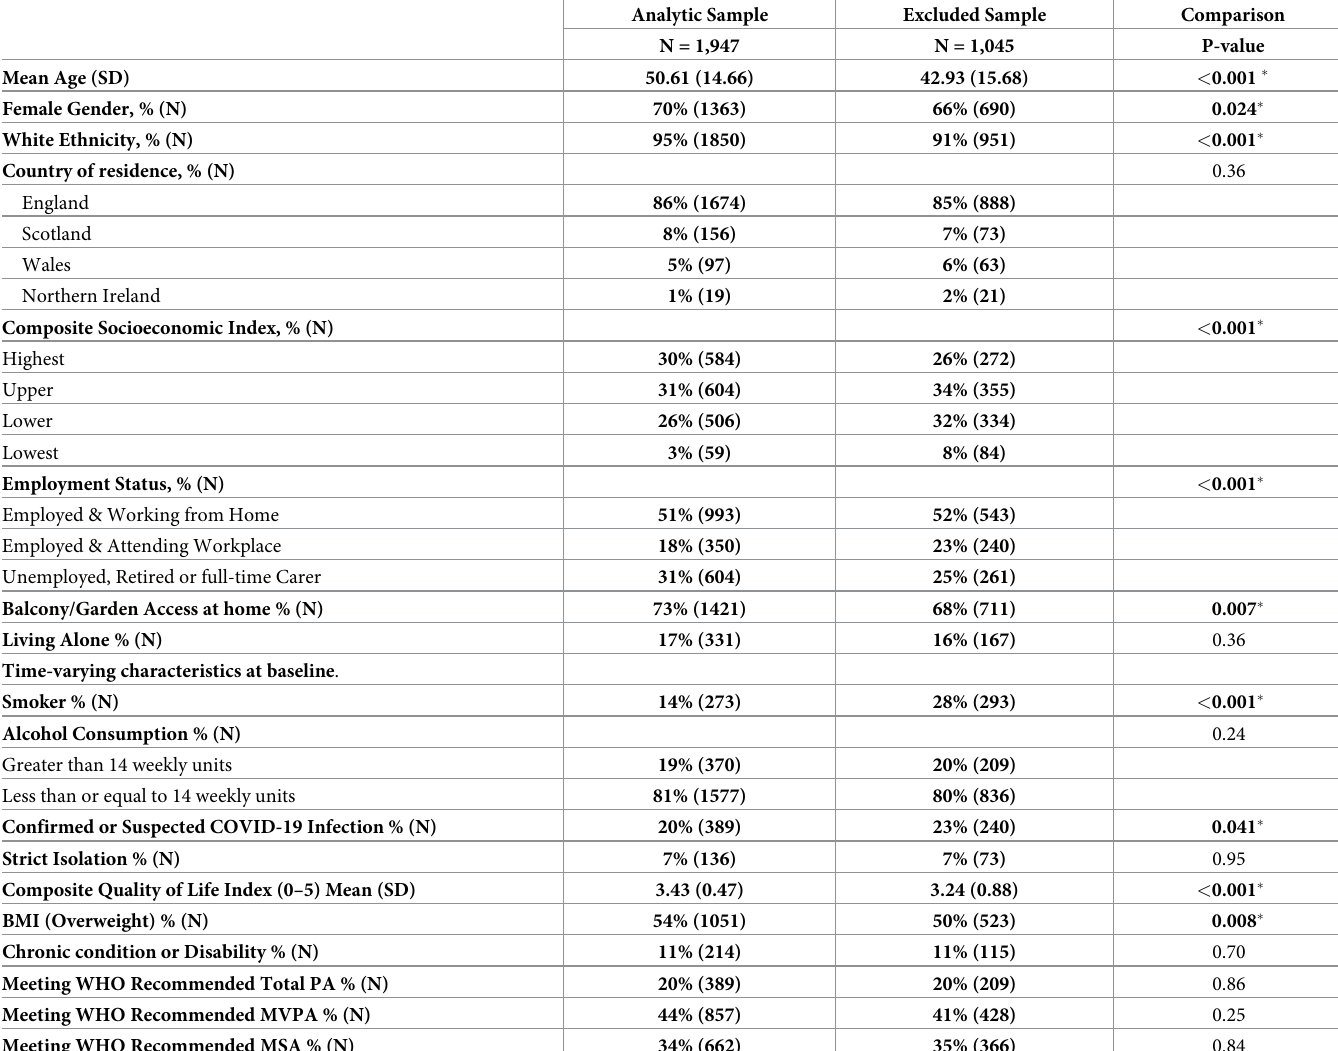
Table 1. Participant demographics at